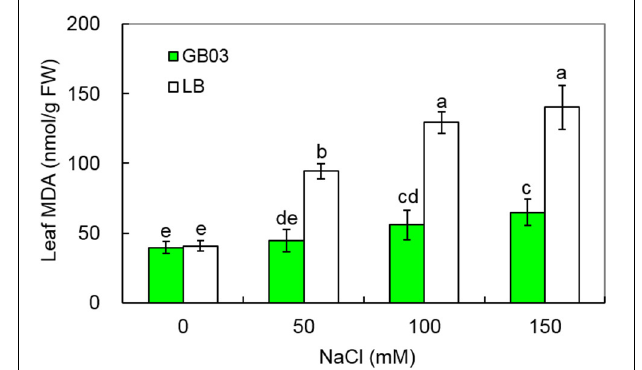
FIGURE 4 | Effects of GB03 bacterization on total chlorophyll content of white clover under various concentrations of NaCl. Values are means and bars indicate SDs ( n = 8). Columns with different letters indicate significant difference at P < 0 . 05 (Duncan test).